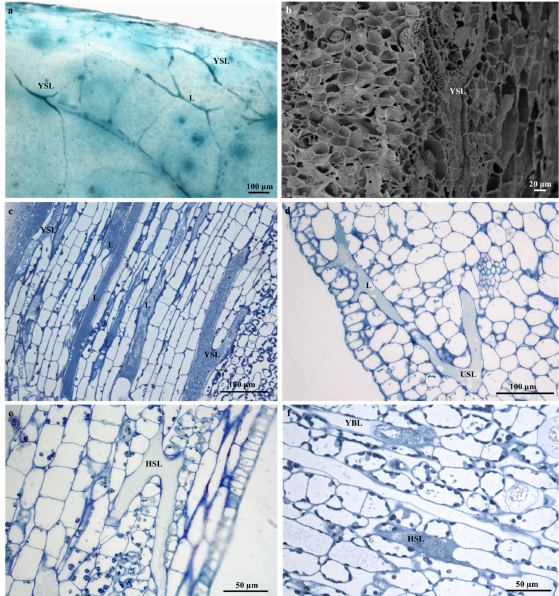
Figure 4. Articulated anastomosing laticifers of T. ventricosa . ( a ) Light micrograph of a whole stained seedling leaf showing a branched network of Y-shaped laticifers. ( b ) Scanning electron microscopy micrograph of a young stem fracture showing a single Y-shaped branched laticifer. ( c ) Light micrograph of sequential sectioned young leaf showing Y-shaped laticifers ( d ) Light micrograph of an emergent leaf section showing a branching laticifer and a U-shaped branched laticifer. ( e ) Light micrograph of a young stem section displaying a branched H-shaped laticifer. ( f ) Light micrograph of a young stem section depicts branched Y- and H-shaped laticifers. Abbreviations: L = laticifer, USL = U-shaped laticifer, YSL = Y-shaped laticifer, HSL = H-shaped laticifer.